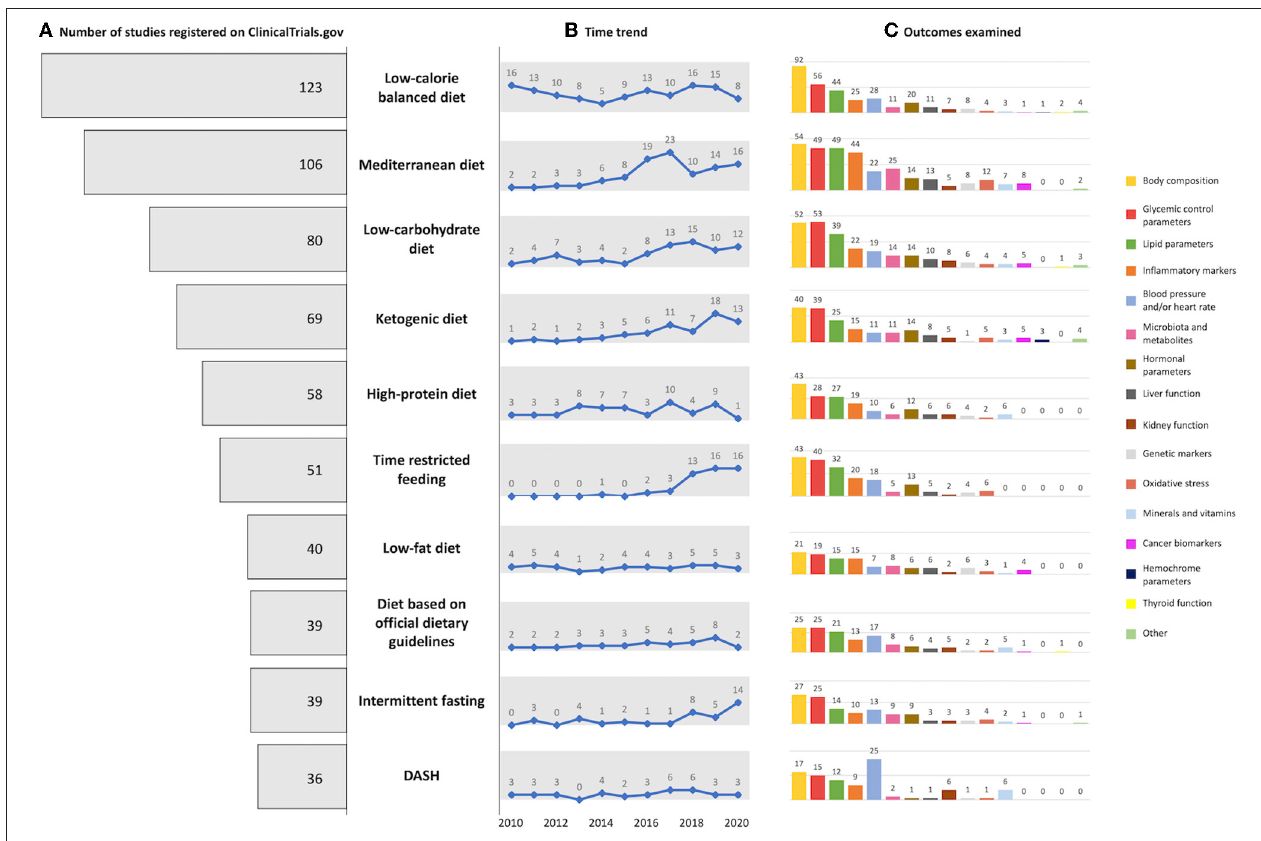
FIGURE 3 | Graphical representation of (A) number of top 10 diets registered on ClinicalTrials.gov, (B) with the related time trend, and (C) examined